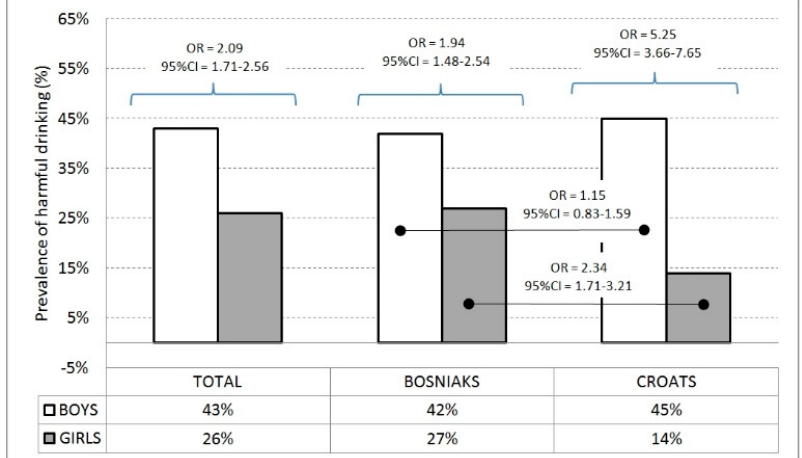
Figure 2. Prevalence of harmful alcohol drinking with odds ratio between and within genders. Percentage of reported frequency for boys (the 100% being 214 and 485 for Croats and Bosniaks, respectively) and girls (the 100% being 558 and 485 for Croats and Bosniaks, respectively).